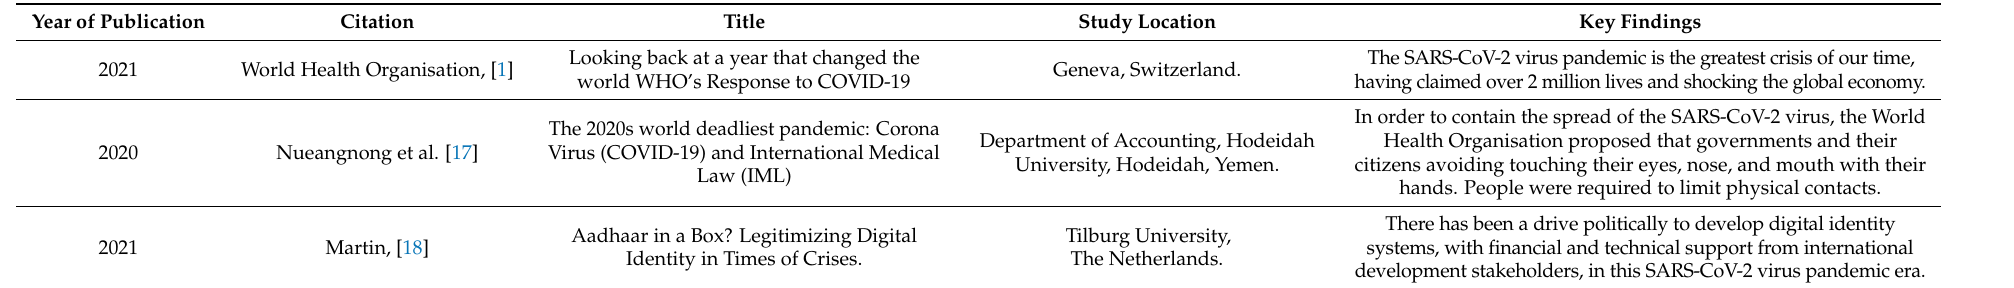
Table 4. Introduction to study analysis.